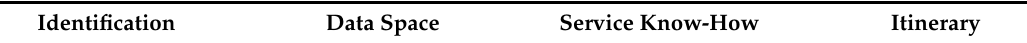
Table 2. Application proxy data